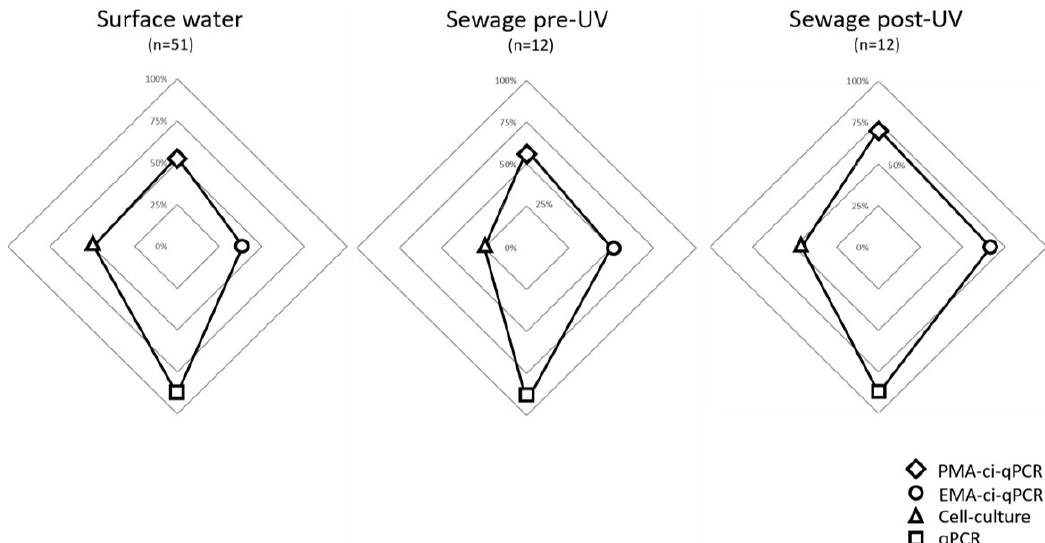
Figure 3. Comparison of the percentages of samples positive for HAdV obtained by azo-dye pretreated ci-qPCR, qPCR, and cell culture for the surface and municipally treated wastewater before and after UV-treatment in the pilot plant. Limit of detection has been calculated as 25 genomic copies per L of sample for molecular methods and 2 infectious virions per mL for the cell